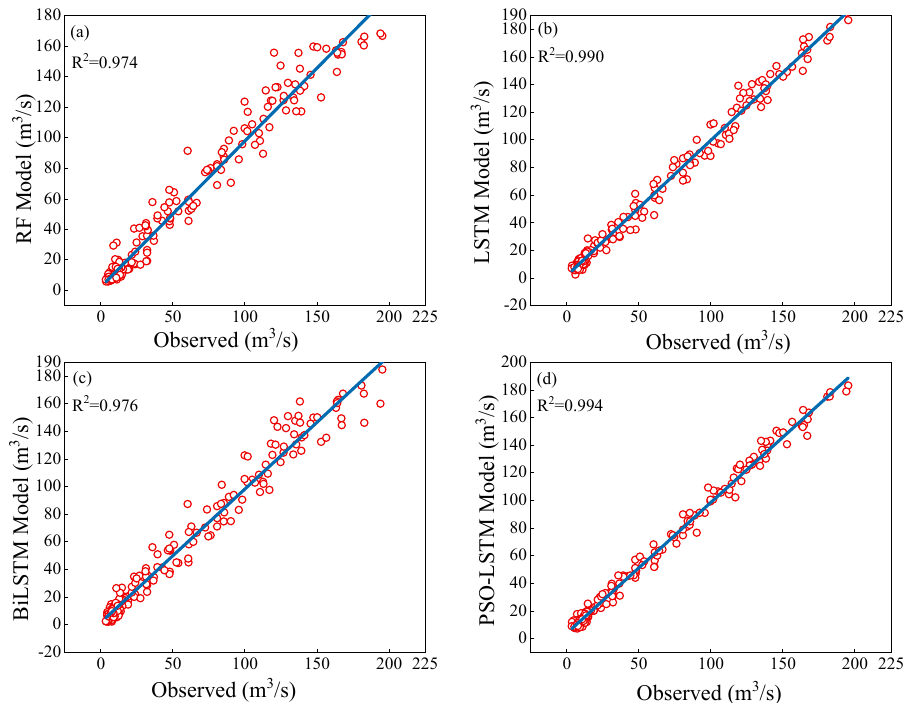
Figure 5. Scatter plots and fitting lines of simulated and observed monthly average runoff for the four models during the training period, with R 2 representing the coefficient of determination. ( a ) RF model; ( b ) LSTM model; ( c ) BiLSTM model; ( d ) PSO-LSTM model.